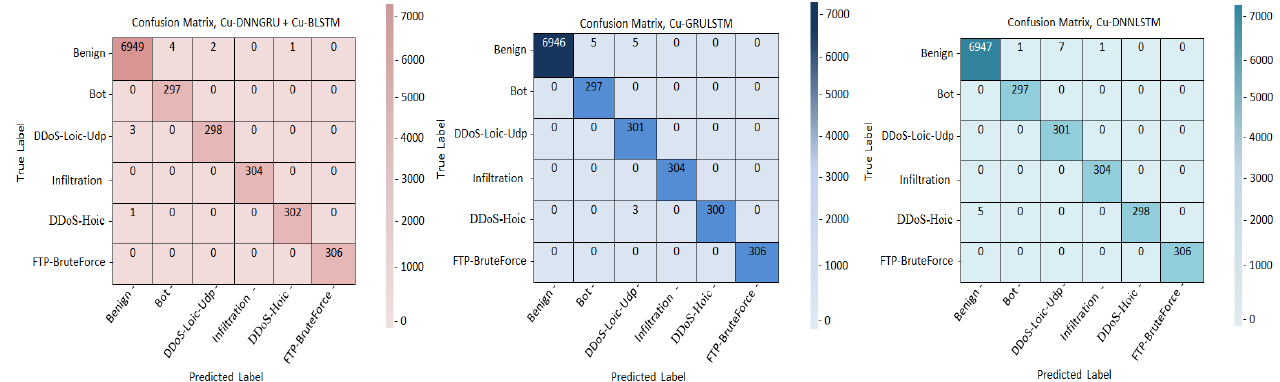
Figure 3. Confusion metrics of Cu-DNNGRU + Cu-BLSTM, Cu-GRULSTM, and